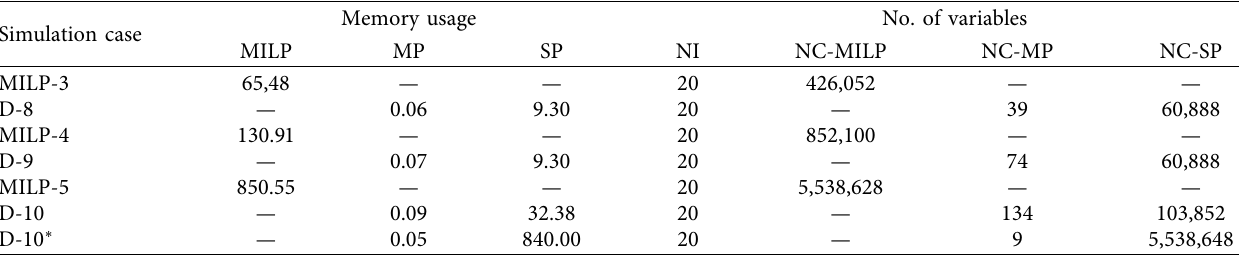
Table 6: Memory usage (in Mb) for MILP, master problem (MP) and one subproblem (SP) and the number of integer variables (NI) and